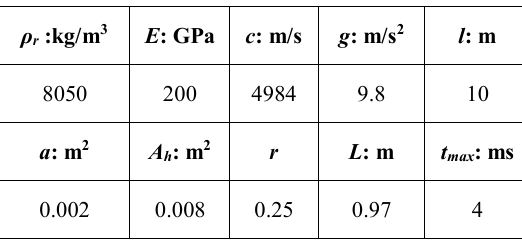
Table 3. Parameters used for the simulated driving